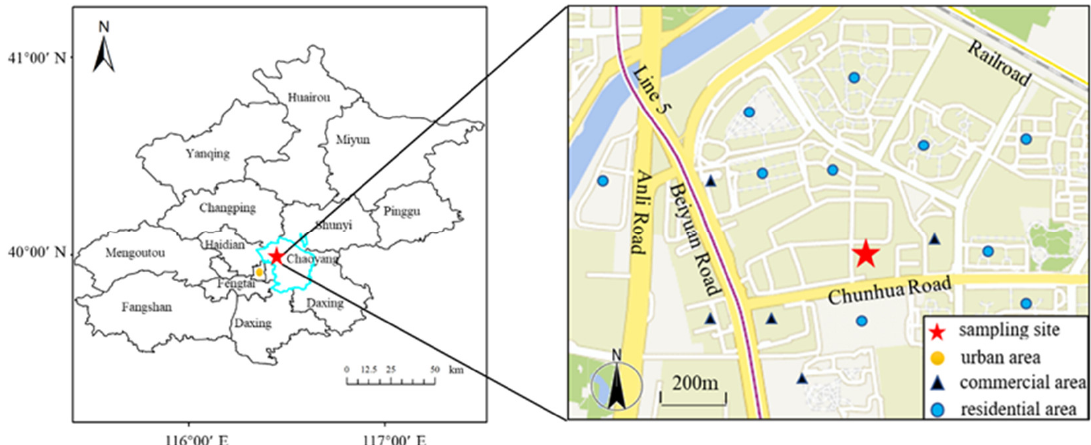
Figure 2. The location of the sampling site.